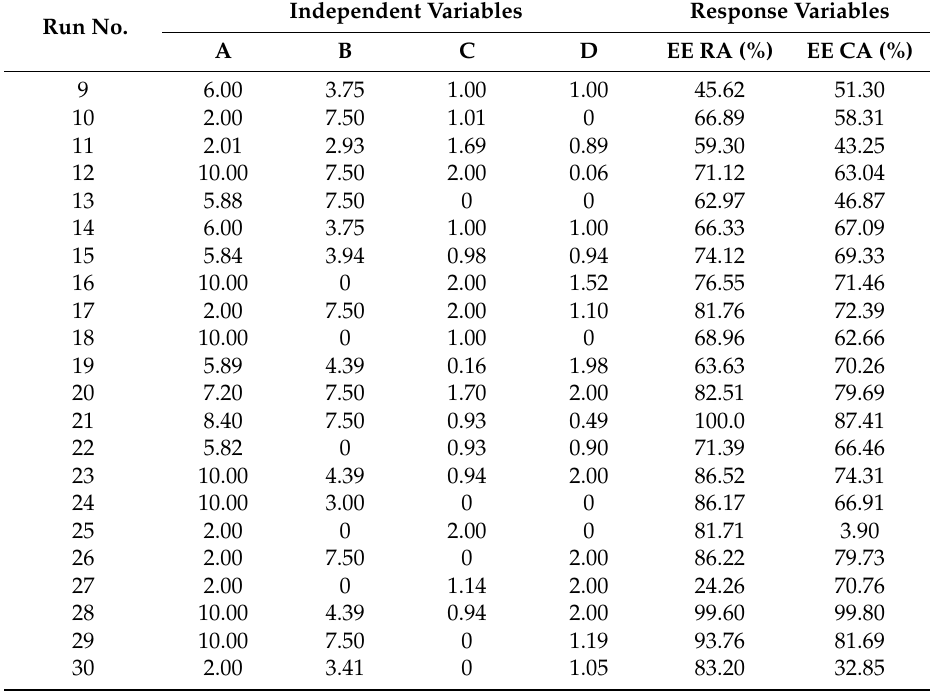
Table 1. D-optimal design with independent and response variables for the preparation of Turkish oregano-loaded microcapsules. Run